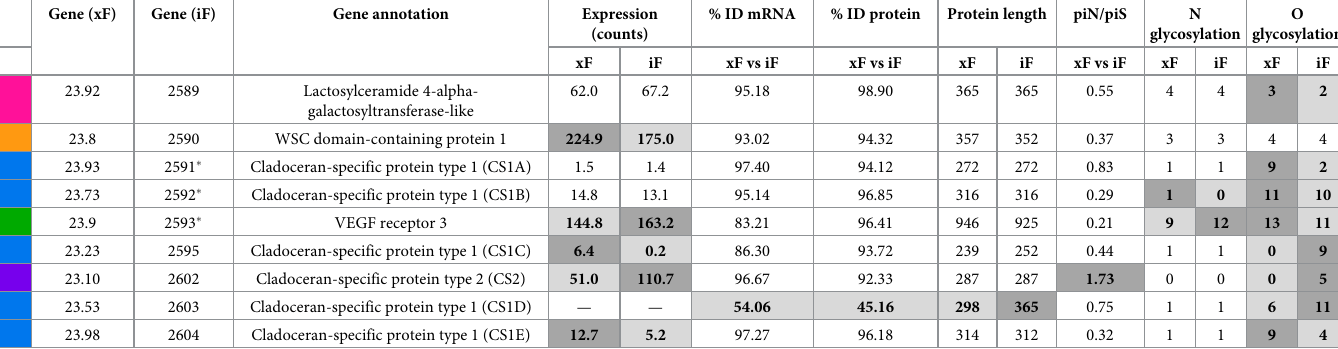
and protein (Table 2). Gene xF 23.53 (iF 2603) is an exception, but this gene is not expressed in either parent and we do not consider it further. Nearly all genes had piN/piS values below 1, the one exception being gene xF 23.10 (iF 2602). The F-locus region contains six Cladoceran-specific uncharacterized genes (xF 23.93, 23.73, 23.23, 23.53, 23.98, and 23.10, and their iF positional homologs; colored in blue and purple in Fig 3A and Table 2) that can be divided into two types belonging to the same large gene family. Protein products from the first five of these genes (CS1) share high sequence similarity ( > 40% similarity to at least one other member of this group and > 35% similarity to all members) and likely arose from recent duplication events (S4 and S5 Figs). Topological similarities between these five paralogs include a predicted transmembrane domain near the C-terminal end as well as a shared intracellular amino acid motif YXXC (YXVC and FXVC in our dataset, see S4 Fig), which is thought to be involved in the JAK/STAT signaling pathway [29]. Predicted pro- tein products from genes xF 23.10 and iF homolog, 2602, do not have this STAT motif and have lower sequence similarity to the CS1 paralogs ( < 30% similarity to all CS1 proteins; S5 Fig), thus we categorize these as type II Cladoceran-specific proteins (CS2). Despite the simi- larities in sequence and overall topology between the CS1 paralogs (within each genome), pairs of xF and iF homologs (between genomes) from all six Cladoceran-specific proteins Table 2. Shared genes within the F-locus region of the QTL parent clones. Gene (xF)